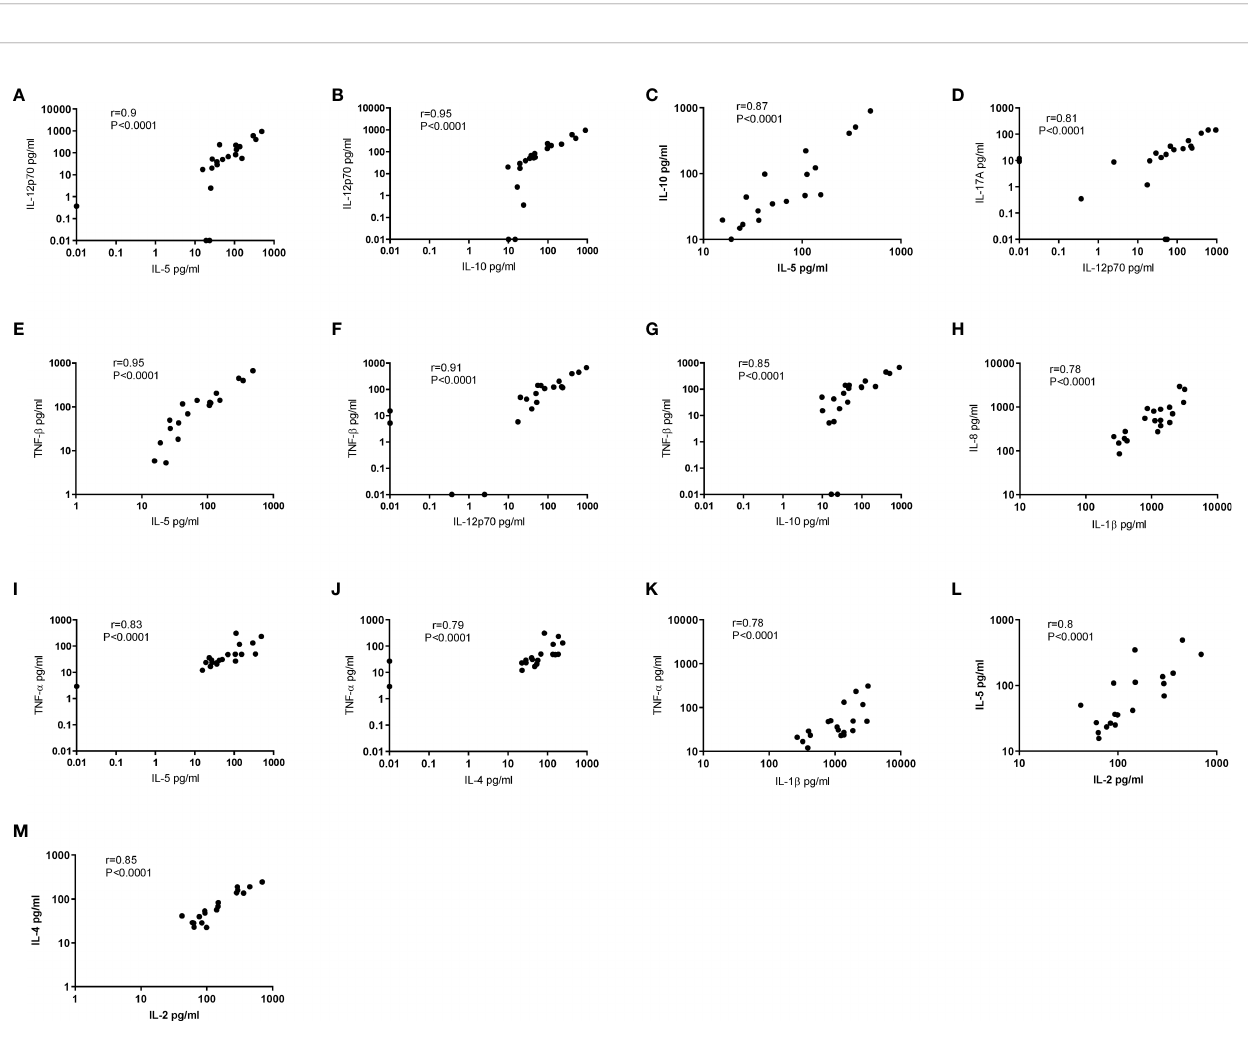
FIGURE 5 | Disease Activity. Normalised cytokine levels differentially expressed in saliva from BD and RAS patients as compared to HC. Graphs show the concentrations of IL-8 (A) , IL-1 b (B) and TNF- a (C) expressed in pg/ml from BD-ALL (N=20), RAS-ALL (N=7) and HC (N=10). The BD patients were further grouped into disease activity relapsed patients BD-RE (N=7) and disease activity quiet patients BD-Q (N=13). Data is presented as median ± IQR. Signi fi cant differences were determined by two tailed Mann-Whitney U test with 95% con fi dence interval (CI). Exact p values